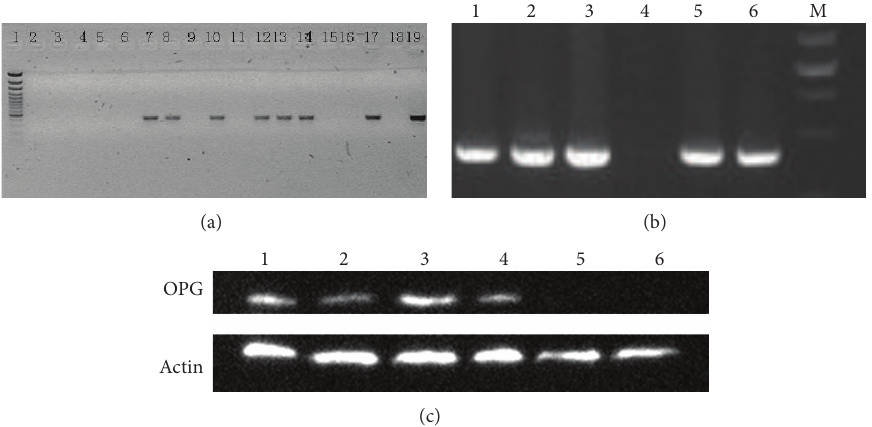
Figure 3: Identification of genotypes of OPG-Tg mice. (a) Identification of OPG genotypes in OPG-Tg founder mice; 1: GenenRuler 100bp DNA Ladder; 2–17: mice samples; 18: ddH2O; 19: positive control. (b) Identification of young mice genotypes. M: GenenRuler100 bp DNA Ladder; 1–3: young pup samples; 4: ddH 2 O; 5-6: positive control. (c) OPG-Tg mice liver’s western blot examination. 1–4: OPG-Tg mouse; 5: WT mouse; 6: H 2 O.